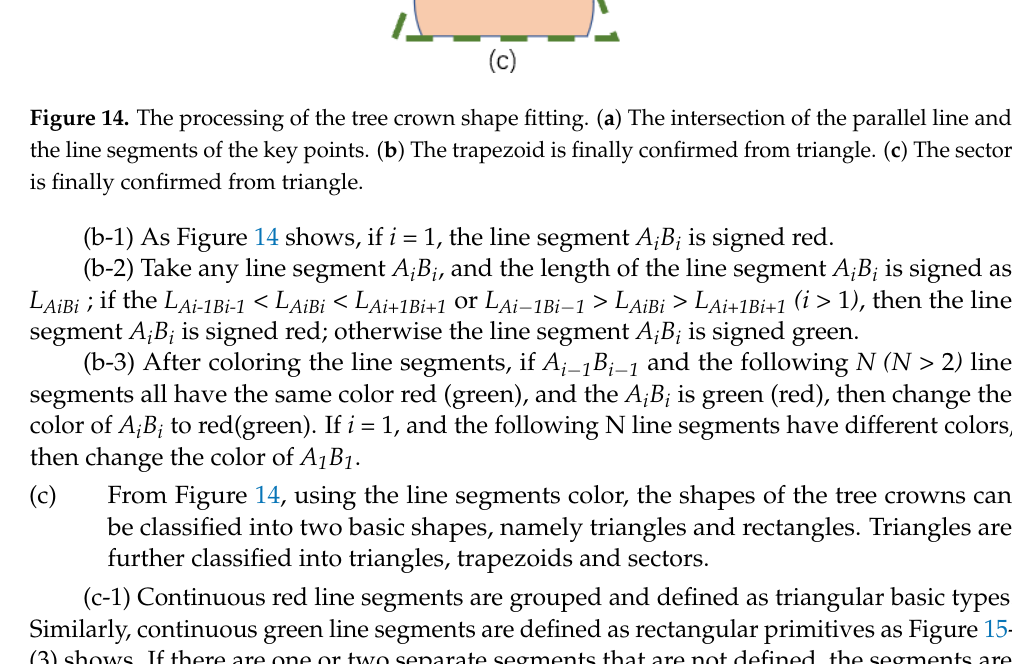
be classified into two basic shapes, namely triangles and rectangles. Triangles are further classified into triangles, trapezoids and